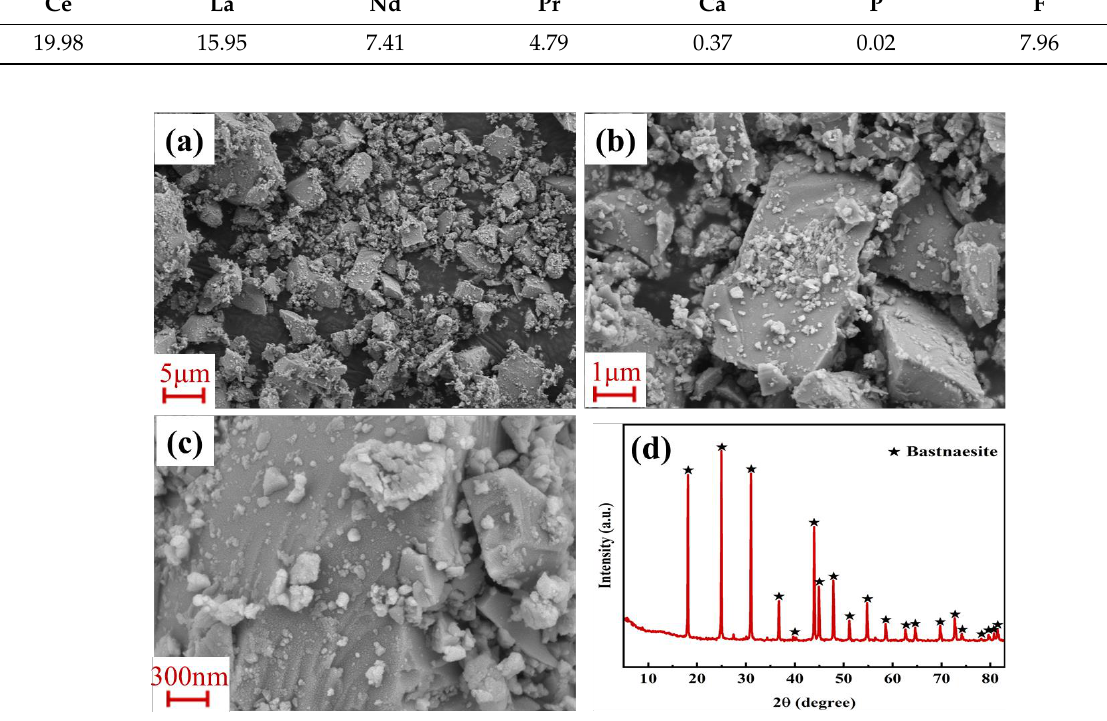
Figure 3. SEM ( a – c ) and XRD ( d ) analysis results of bastnaesite.